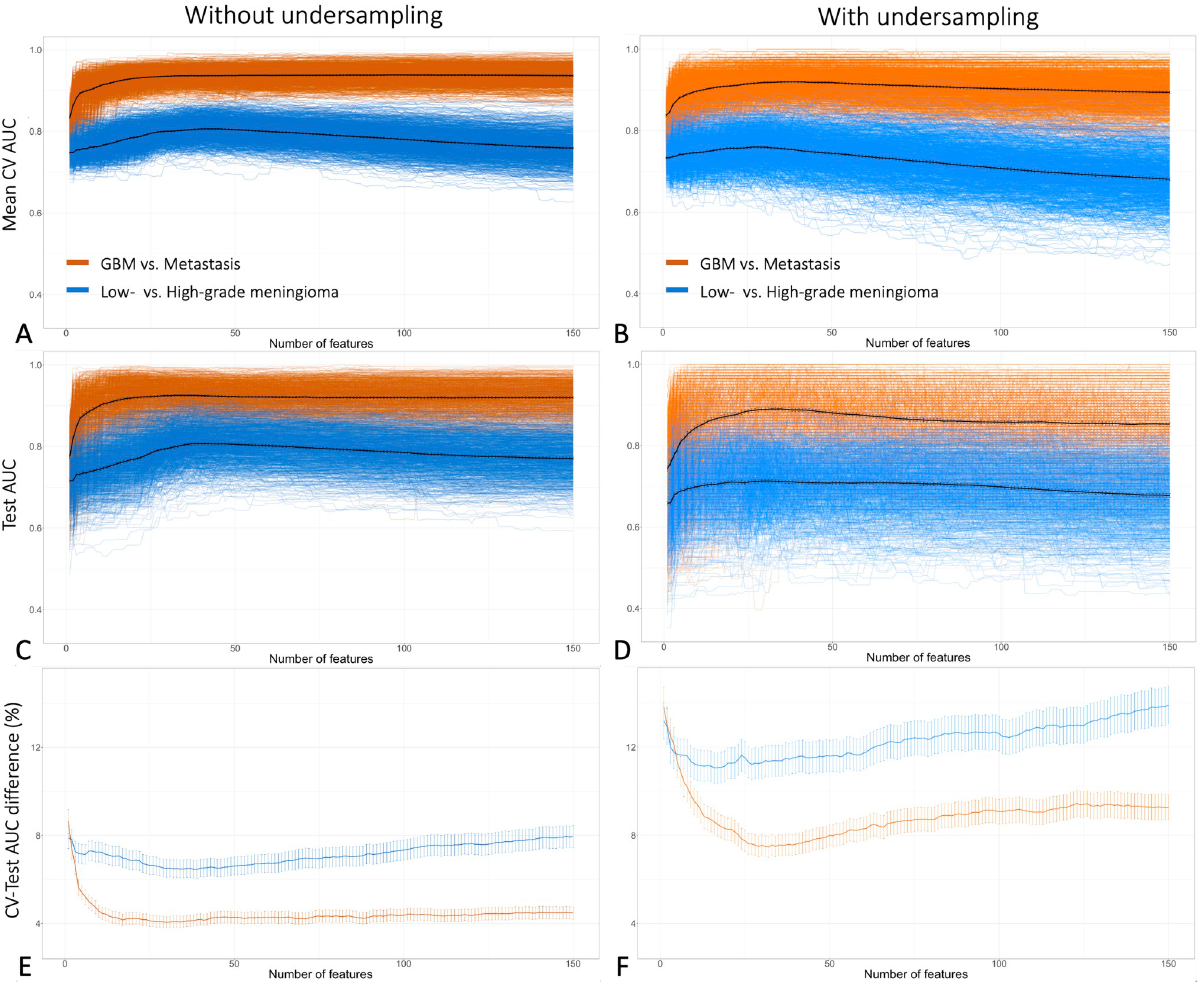
Fig 2. The relationship between the number of input features and the variability in estimated and test model performance by 1,000 different random data splits. A , B, C, and D : Each colored line indicates a result from a single random training-test set split, and each thick black line shows the average of the results from 1,000 data splits in relation to the number of features: mean cross-validated AUC without ( A ) or with undersampling ( B ), and test AUC without ( C ) or with undersampling ( D ). On average, AUC increased in the beginning and later decreased with increased number of features. However, without averaging, in some trials the AUC did not decrease even at higher numbers of features, widening the AUC variability by the data splits with increased number of features. E and D : Each colored line indicates the average of the percentage AUC differences between CV and testing (i.e., generalization gap) from 1,000 data splits in relation to the number of features, with datasets without ( E ) or with undersampling ( F ). The vertical lines indicate 95% confidence intervals. Note that all these trends were more pronounced with the difficult task (i.e., meningioma grading) and with